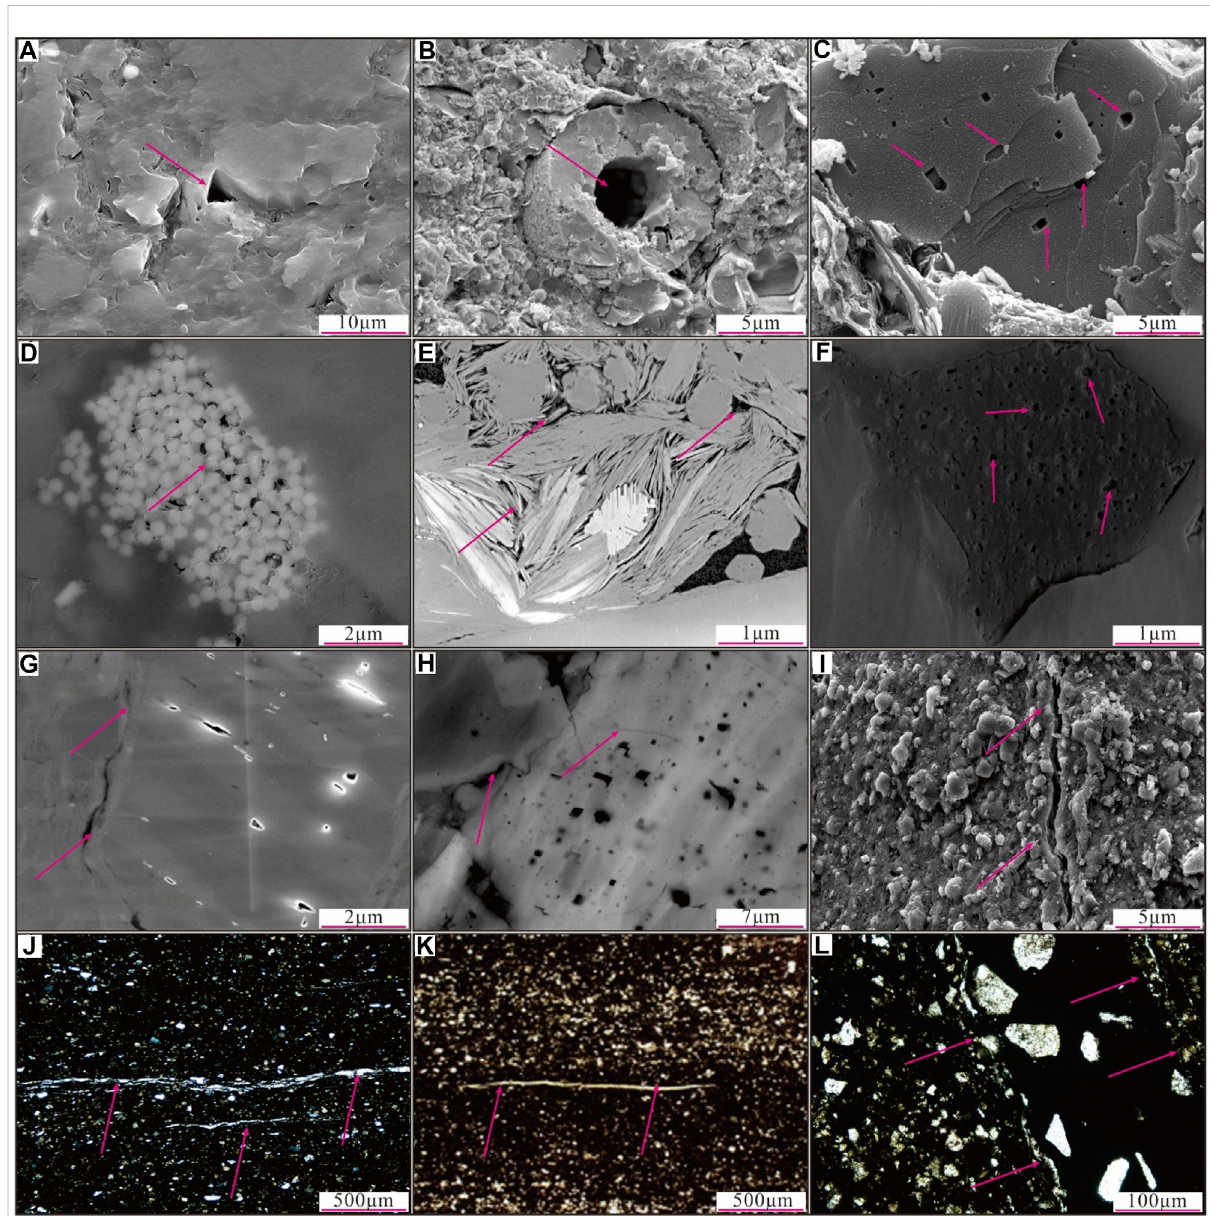
FIGURE 2 Microscopic pore types and characteristics of the Longmaxi Formation shale in the Changning area. (A) N216, 2,302.5 m, clay mineral particles supporting residual pores; (B) N216, 2,316.7 m, biological cavities developed inside biological particles; (C) . ZK 2 , 2,233.8 m, intragranular dissolution pores; (D) . ZK 2 , 233.95 m, intracrystalline pores of strawberry pyrite; (E) . N216, 2,308.2 m, intracrystalline pores developed between the crystals of clay minerals; (F) . ZK 2 , 2,214.37 m, organic pores with a honeycomb distribution; (G) . N201, intracrystalline fracture; (H) . N216, fracture in the crystal; (I) . N216, diagenetic contraction fracture; (J) . N216, bedding fracture; (K) . N216, hydrocarbon expulsion contraction fracture; (L) . N216, dissolution